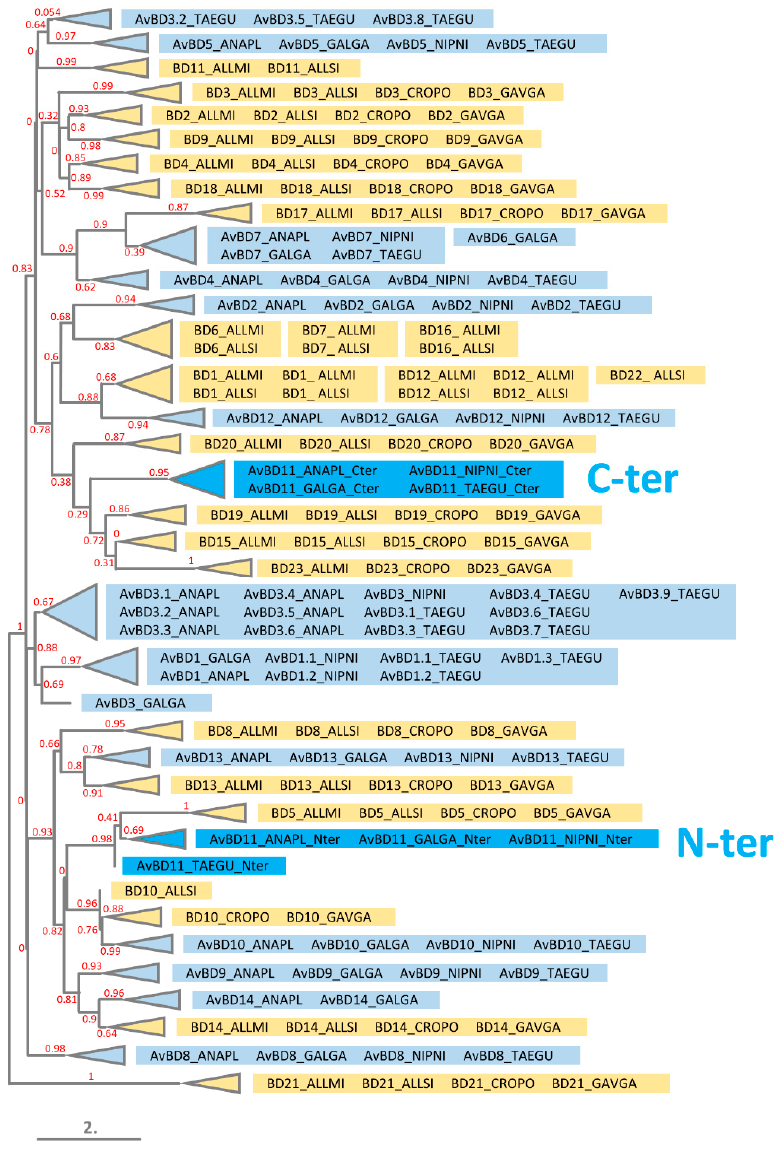
Figure 6. Phylogenetic relationships of the N-terminal (N-ter) and C-terminal (C-ter) domains of AvBD11 with monodomain AvBDs and crocodile beta-defensins. The phylogenetic tree was constructed using the maximum-likelihood-based program PhyML from MAFFT-based alignments adjusted to the length of N-ter and C-ter AvBD11. Branch support values are indicated in red. Bird and crocodile β -defensins are highlighted in blue and in yellow, respectively. Bird species acronyms: ANAPL, Anas platyrhynchos (duck); GALGA, Gallus gallus (chicken); NIPNI, Nipponia nippon (crested ibis); and TAEGU, Taeniopygia guttata (zebra finch). Crocodile species acronyms: ALLMI, Alligator mississippiensis (American alligator); ALLSI, Alligator sinensis (Chinese alligator); CROPO, Crocodylus porosus (saltwater crocodile); and GAVGA, Gavialis gangeticus